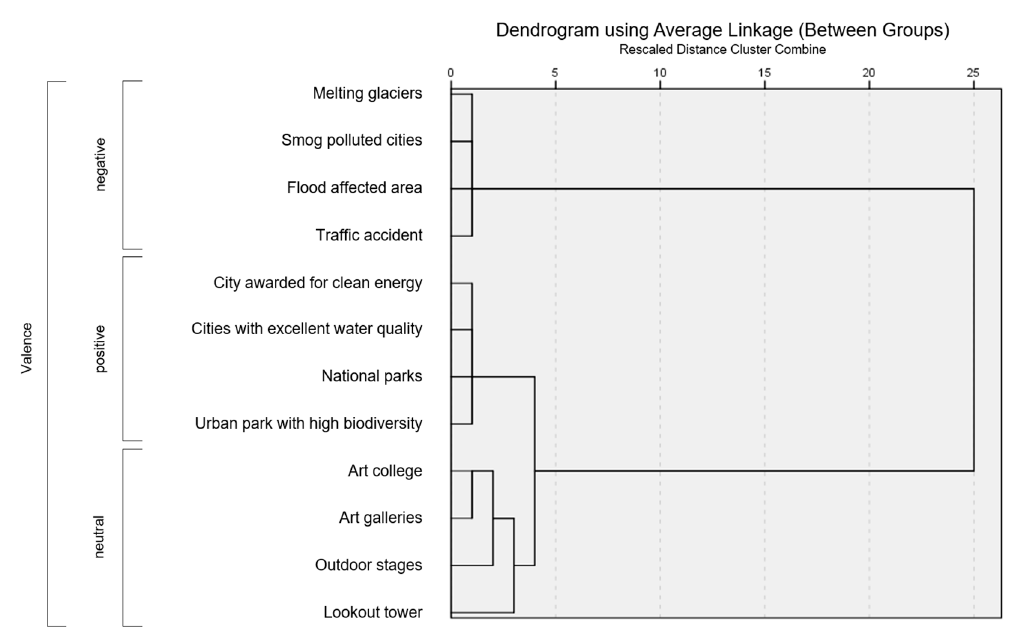
Figure 2. Dendrogram based on agglomerative hierarchical cluster analysis of topic valence ratings.